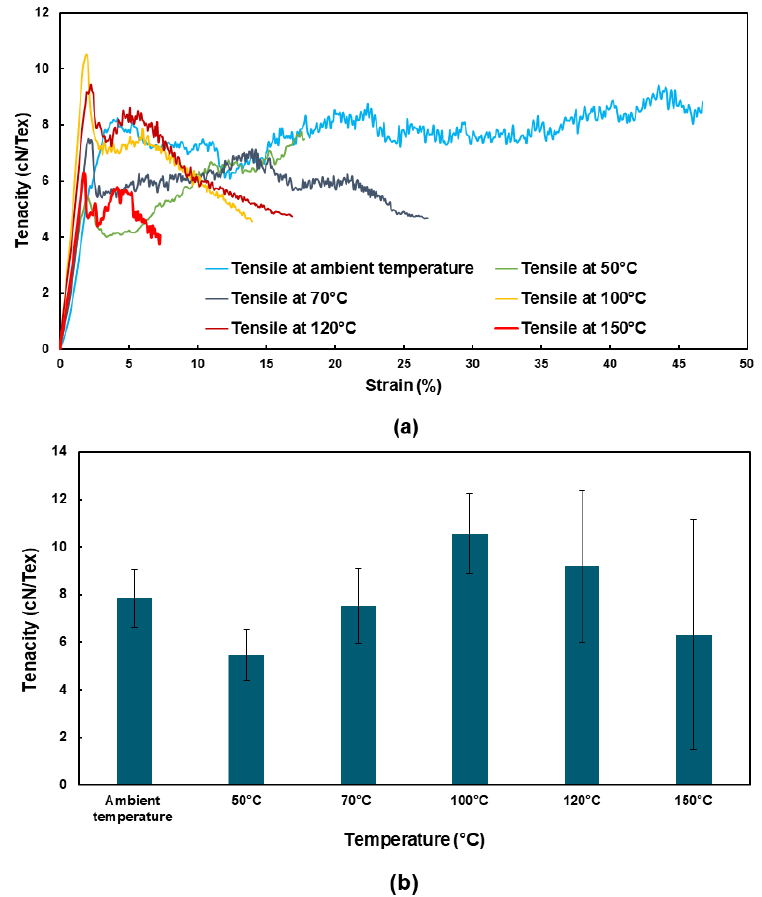
Figure 7. ( a ) Tenacity–strain curve of the hybrid yarns at different temperatures; ( b ) tenacity at first peak at different temperatures.